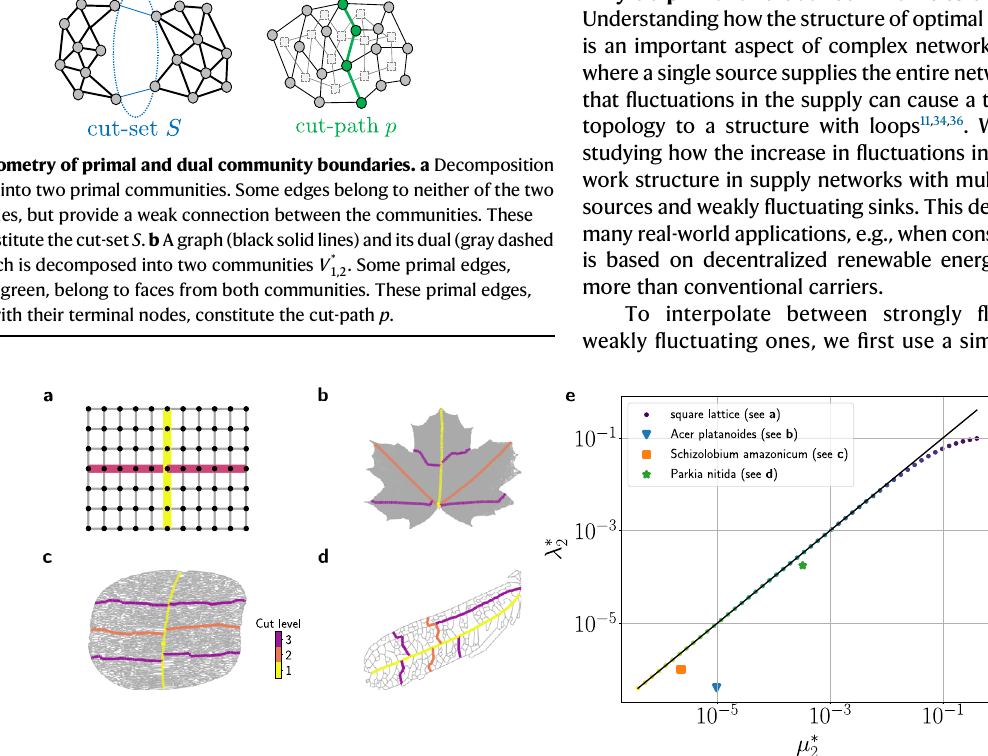
community boundary (yellow) constitutes a cut-path p . e Comparison of the dual algebraic connectivity λ * 2 and the dual topological connectivity μ * 2 de fi ned in Eq. (12). Circles refer to the case of the square lattice with the color of the circles indicating the fraction w 1 / w 0 . The topological connectivity μ * 2 provides a rigorousupperboundfor λ * 2 ,butalsoagoodapproximationforlargeparameter regions.Thiscorrespondenceshowshowdualcommunitiesaredecomposedby a strong connectivity along the